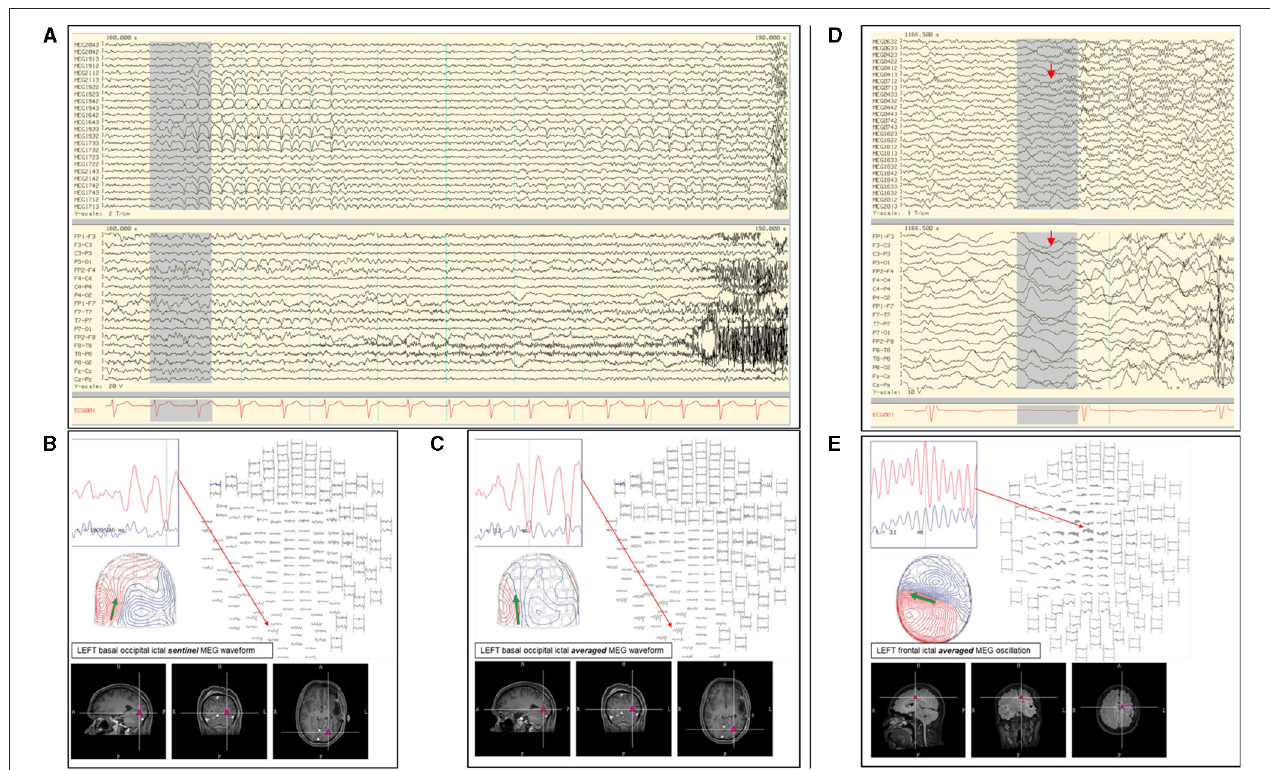
FIGURE 7 | (A) Ictal MEG-EEG recording of a patient showing MEG onset at the left occipital channels (MEG1922; MEG1942; MEG1933; MEG1733) with corresponding left parieto-occipital EEG changes. Single ECD analysis of (B) sentinel MEG sharp wave and (C) averaged MEG rhythmic activity showed consistent localization at the left inferior occipital lobe. (D) Ictal MEG of a patient with broad left hemispheric encephalomalacia who lacked interictal MEG and EEG discharges, with ictal EEG onset showed oscillating activity over the left mid-parasagittal region and MEG channels showing a corresponding sustained faster frequency (MEG0712). (E) Early oscillating signals during the initial 120ms were averaged showing a dipolar field suitable for modeling, which was localized to the left frontal region and used to guide